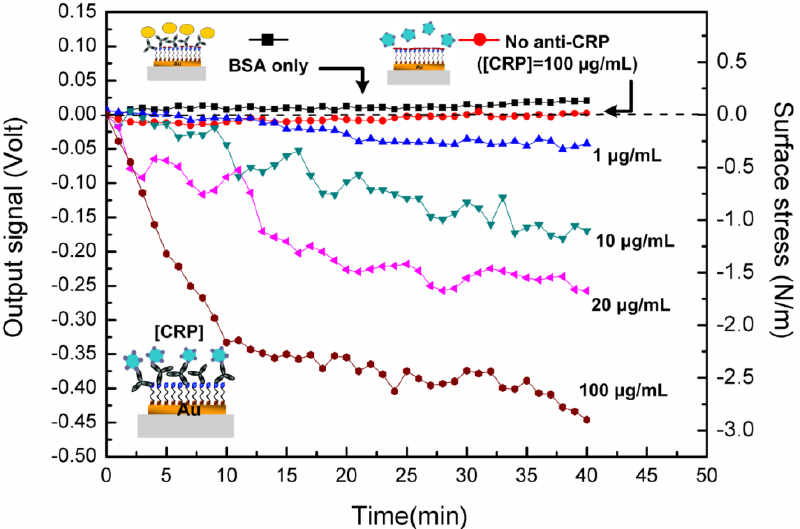
Figure 4. The electrical detection of various CRP concentrations between 1 μg/mL and 100 μg/mL was performed as a function of time using the single free-standing, thermally stable microcantilever biosensor. Specificity and no false positives were confirmed by negligible deflections of the non-immobilized microcantilever with an injection of 100 μg/mL CRP, and of the immobilized microcantilever with the injection of bovine serum albumin (BSA) in a high 1,000 μg/mL concentration. The responses were the amplified